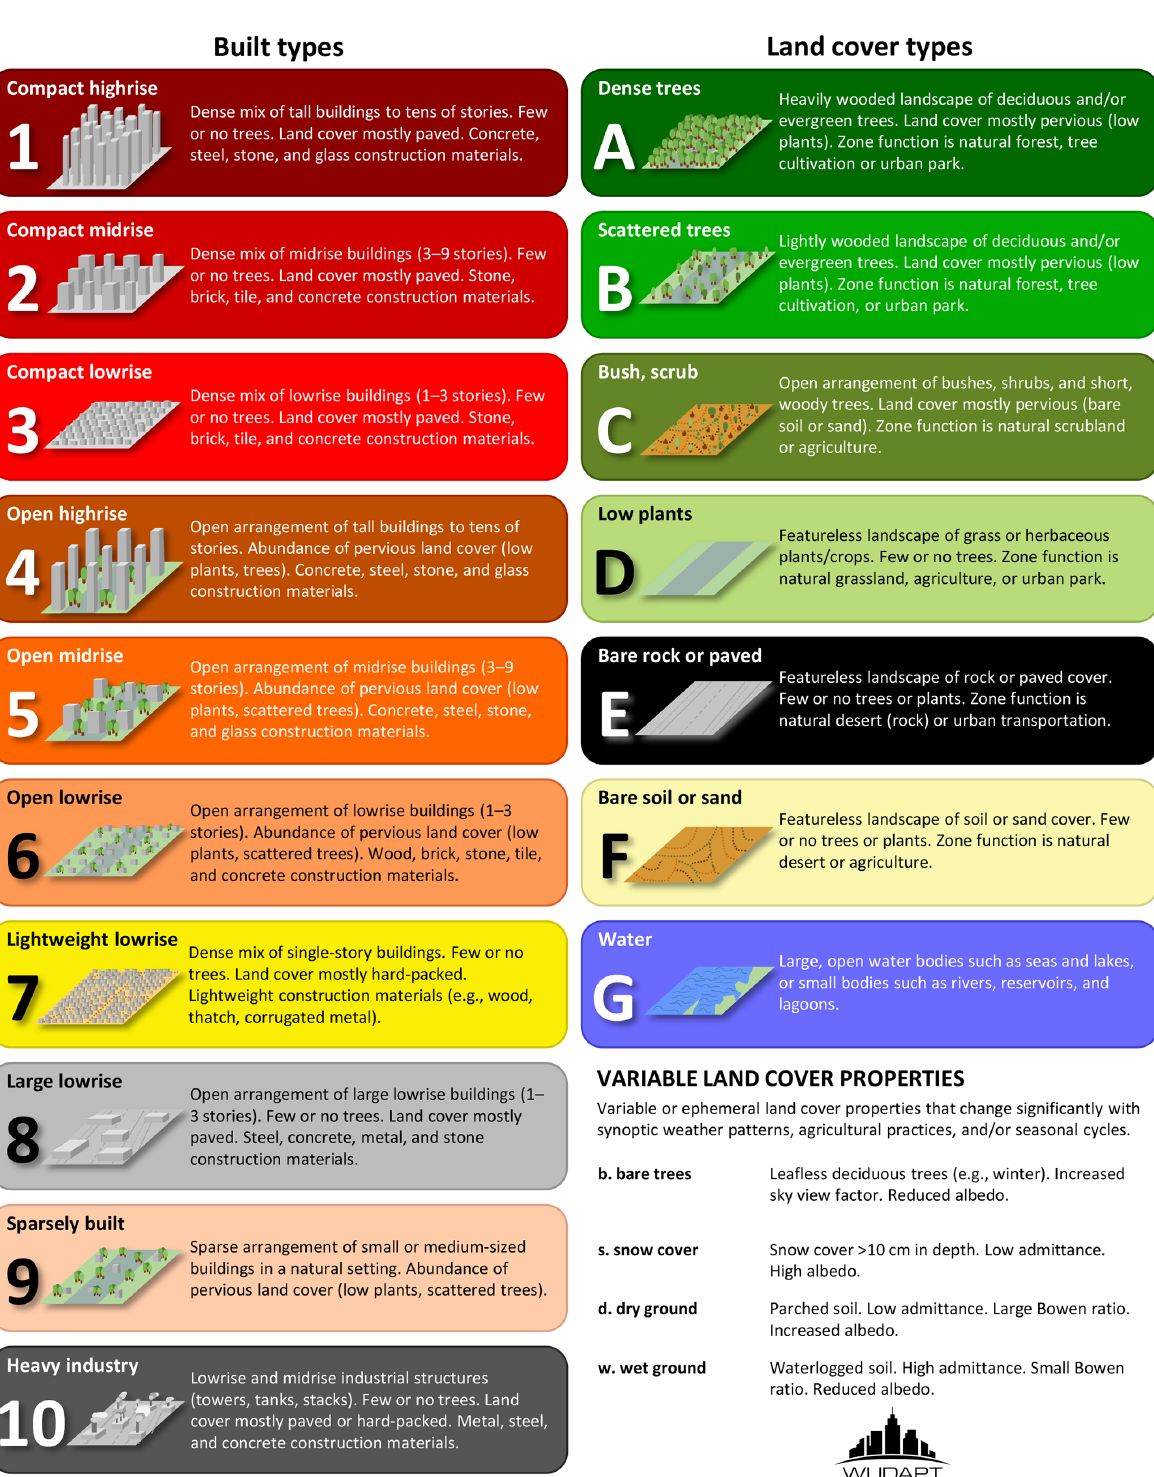
Earth Syst. Sci. Data, 14, 3835–3873, 2022